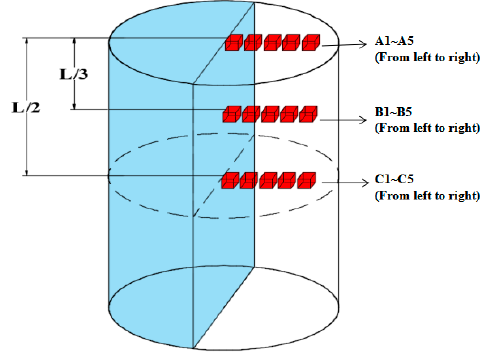
Figure 1. Sampling diagram.